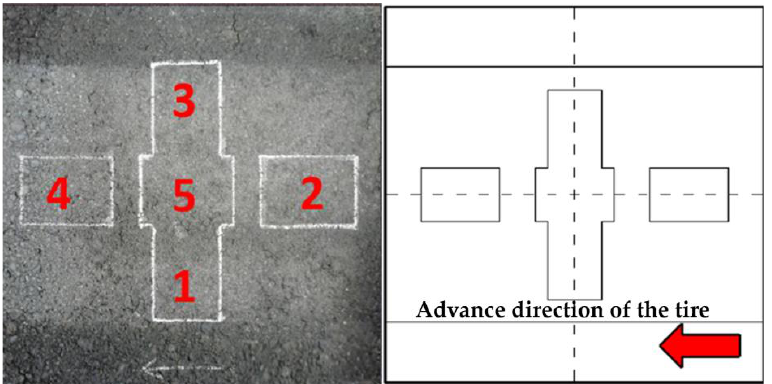
Figure 3. Illustration of abrasion test